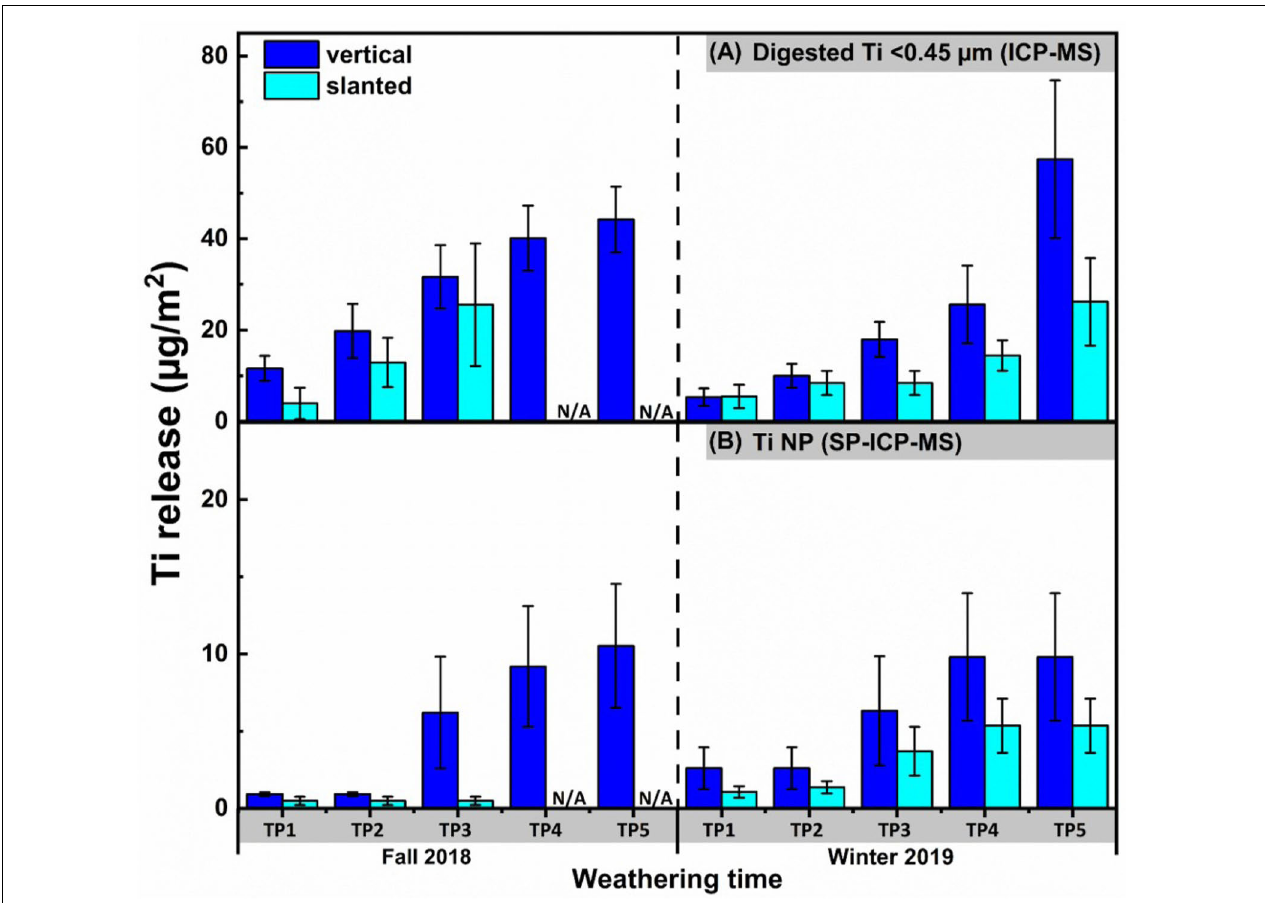
FIGURE 3 | Cumulative concentrations of sub-0.45- µ m Ti determined by (A) ICP-MS on acidified samples and (B) SP-ICP-MS, obtained by integration of the NP peaks. Ti was measured following its release from the painted surfaces in vertical and slanted exposure modes (N = 4 for each condition). Release was normalized by the surface area of the painted panels that were subject to weathering and corrected for the pre-existing natural background in the precipitation. Measurements were performed using a magnetic sector ICP-MS. N/A denotes two samples that were lost.